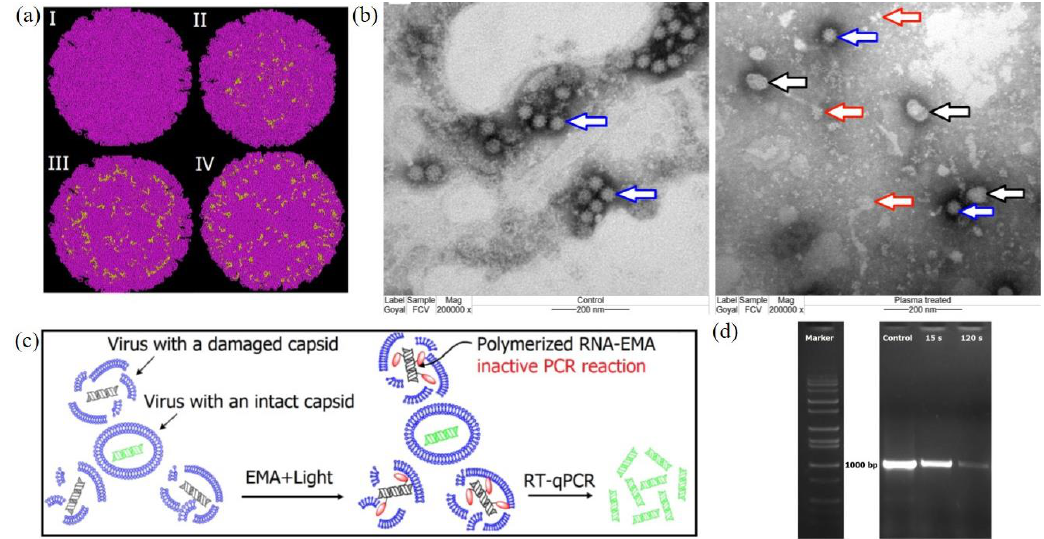
Figure 8. The CAP − triggered damage on FCV. ( a ) TEM imaging of calicivirus the control ( left ) and the experimental group (15s, right ). Blue arrows, black arrows, and red arrows refer to untreated virus particles, distorted viral particles, and the debris of the damaged viral particles, respectively. ( b ) The calculated location of oxidized peptide residues (yellow colored) among the N − terminal arm (NTA) domain (I); shell (S) domain (II); P1 subdomain (III); and P2 subdomain (IV). ( c ) The principles of the quantification of capsid destruction due to CAP treatment. Reverse transcription PCR (RT-PCR) was used to quantify the unaffected calicivirus’s RNA. ( d ) The agarose gel (DNA) patterns of EMA-coupled RT-PCR products from viral RNA obtained from control, 15 s, and 120 s of CAP treatment [48].